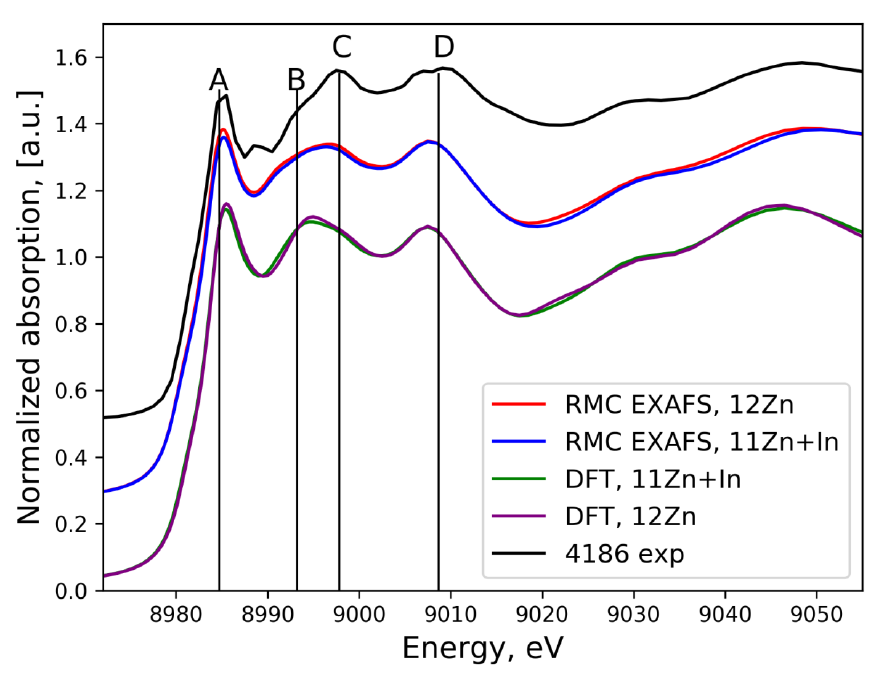
Figure 6. Comparison of calculated and experimental Cu K -edge XANES spectra.